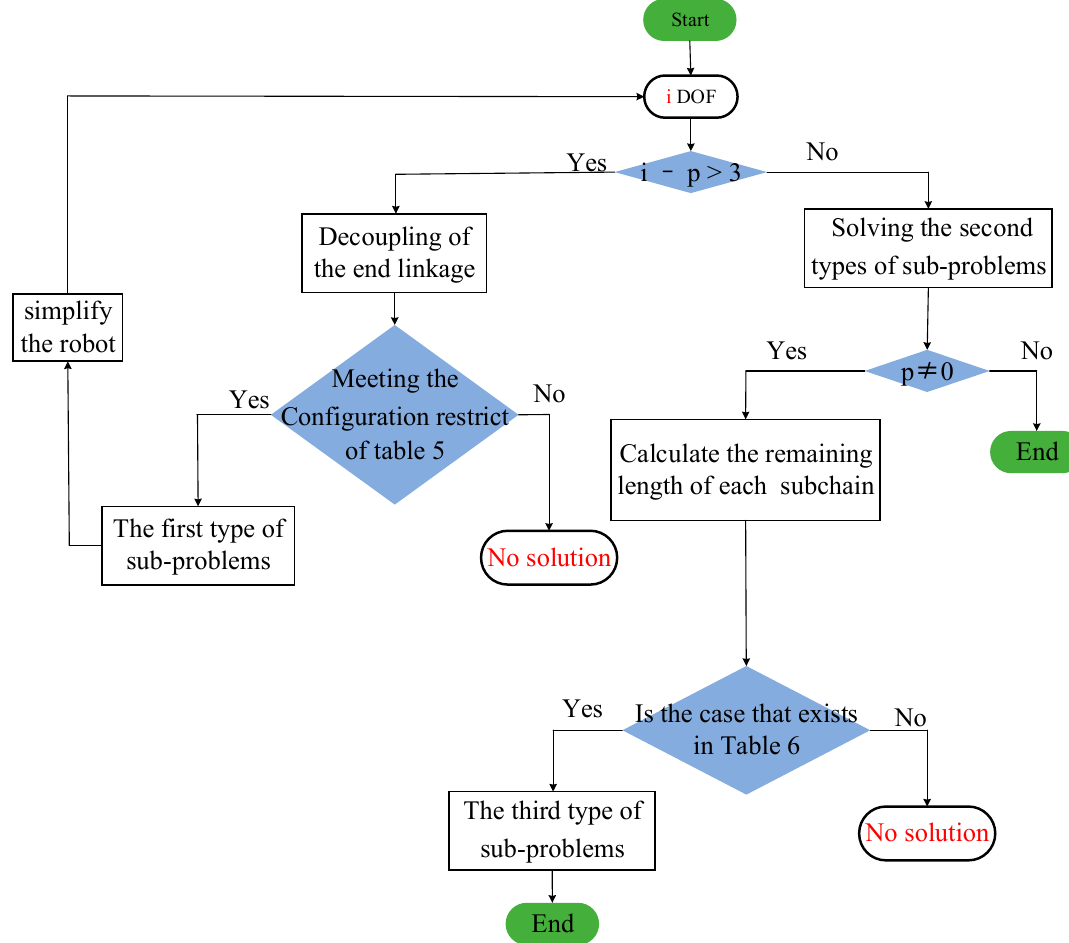
Figure 2. Logic for the universal inverse kinematics algorithm.